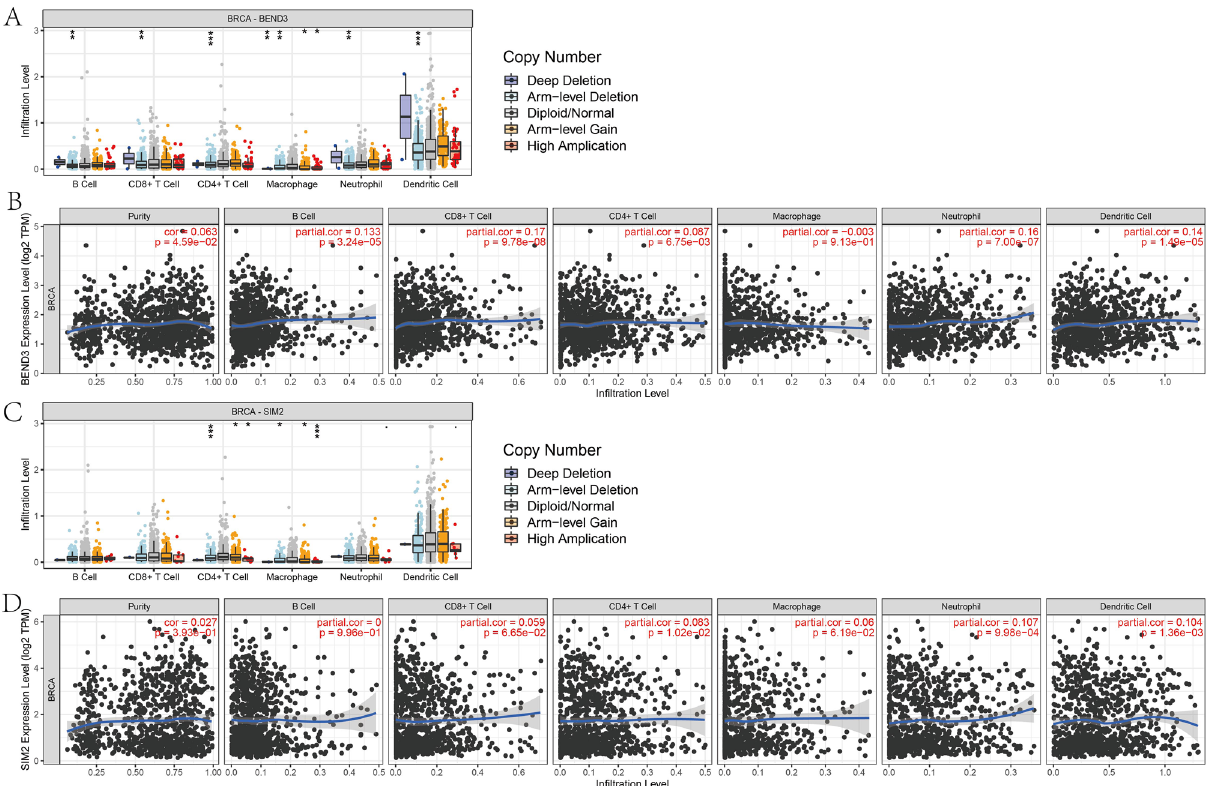
Figure 11. Comprehensive analysis of BEND3 ( A , B ) and SIM2 ( C , D ) and tumor immune microenvironment based on the TIMER